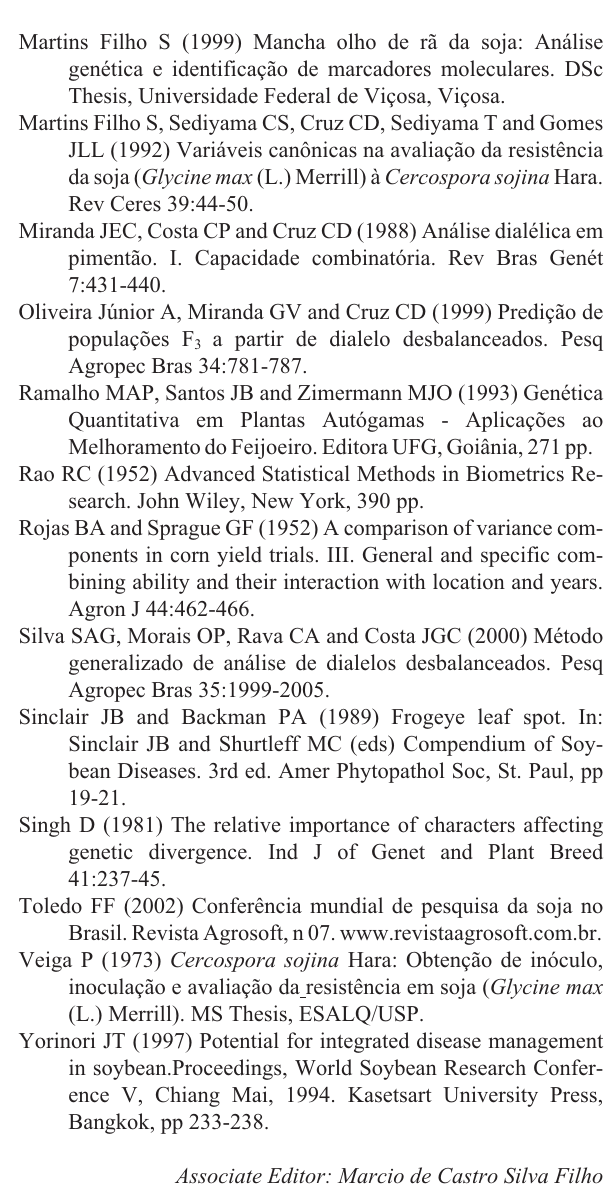
Table 3 - Estimates of the specific combining abilities ( $ s cultivars and their 21 hybrid combinations, in a diallel cross.